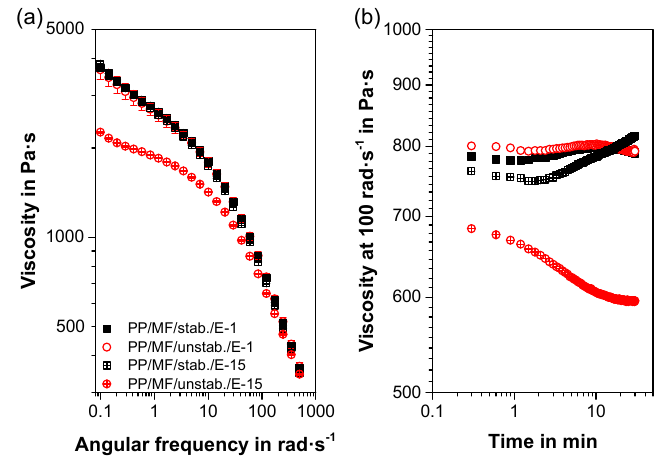
Figure 7. Mean frequency sweep and error bars of three individual measurements ( a ) and time sweep ( b ) for the two composites extruded 1 and 15 times, measured at 220 °C.